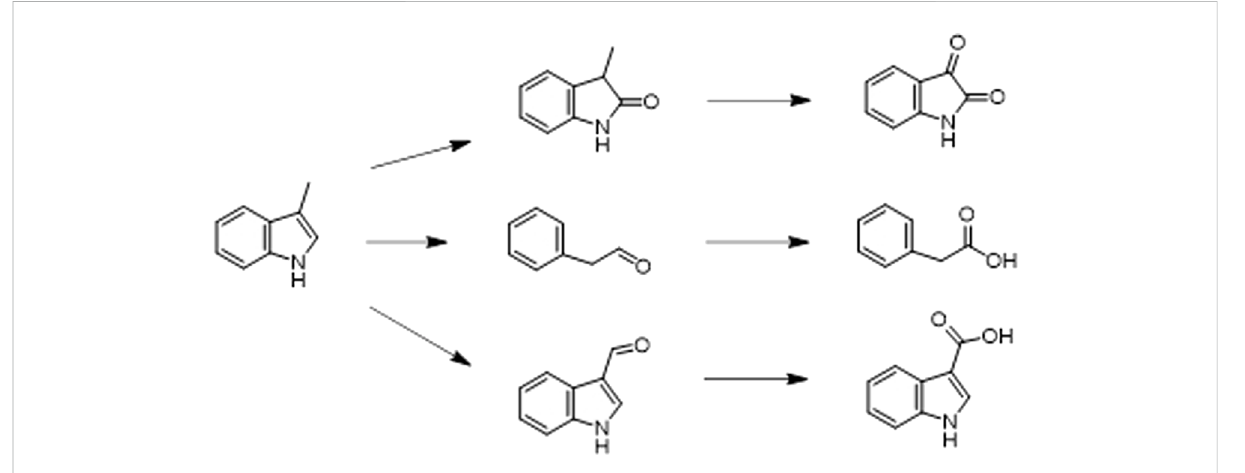
FIGURE 8 Chemical structural formulae of possible 3-methylindole metabolites.